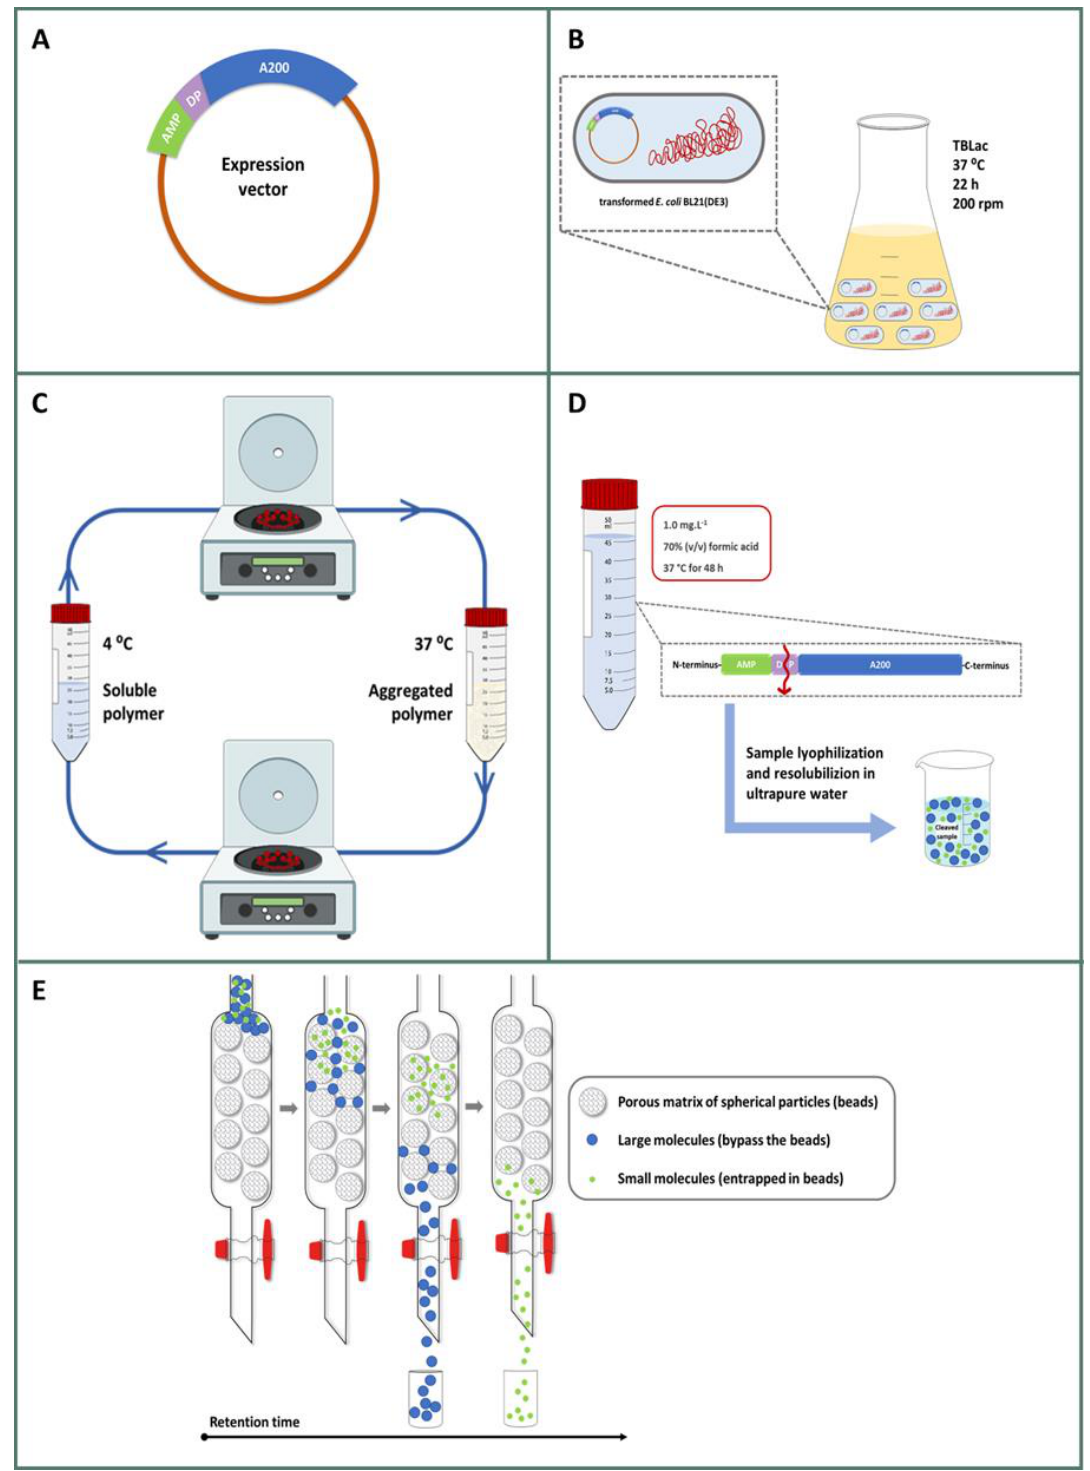
Figure 2. Schematic representation of the overall process used for the production and purification of the antimicrobial peptides. ( A ) AMPs (Synoeca and CM4) are cloned at the N-terminus of A200 previously cloned in an expression plasmid, with the inclusion of a formic acid cleavage site (DP) between the sequences. ( B ) Cells transformed with the expression plasmid are grown in auto-induction medium (TBLac) for 22 h at 37 °C. ( C ) Polymers are purified by inverse transition cycling (ITC) and after lyophilization, ( D ) pure polymers are dissolved in 70% formic acid for protein cleavage for 48 h at 37 °C. Reaction is stopped with mQ water and the sample is freeze-dried and then resolubilized in mQ water. ( E ) AMPs are finally isolated and purified by size-exclusion chromatography (SEC).